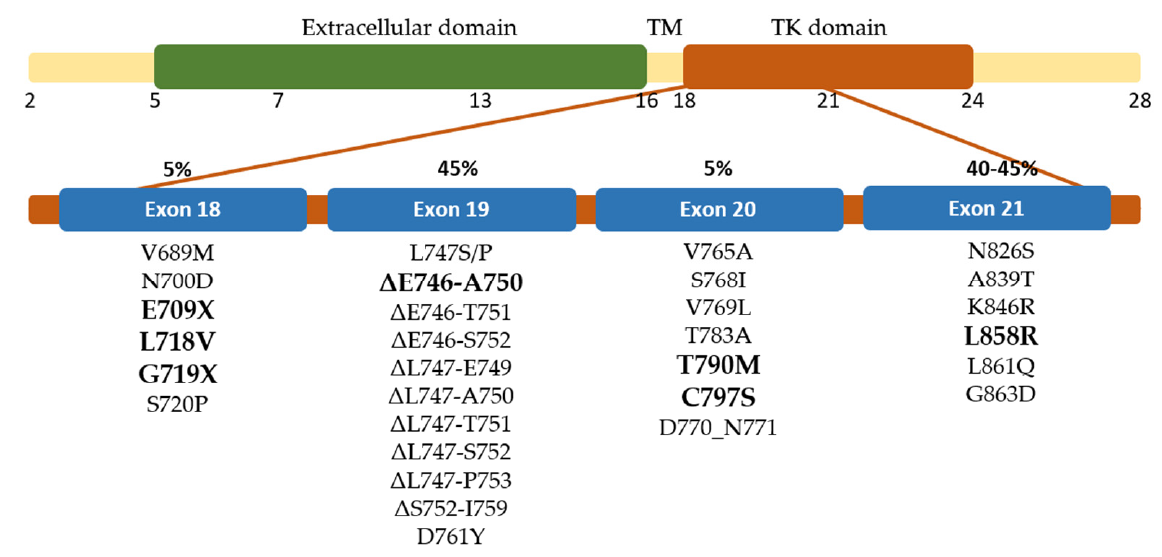
Figure 1. Distribution of exons encoded EGFR and the mutation site of EGFR in NSCLC patients. The most common mutations in each exon are shown in bold.